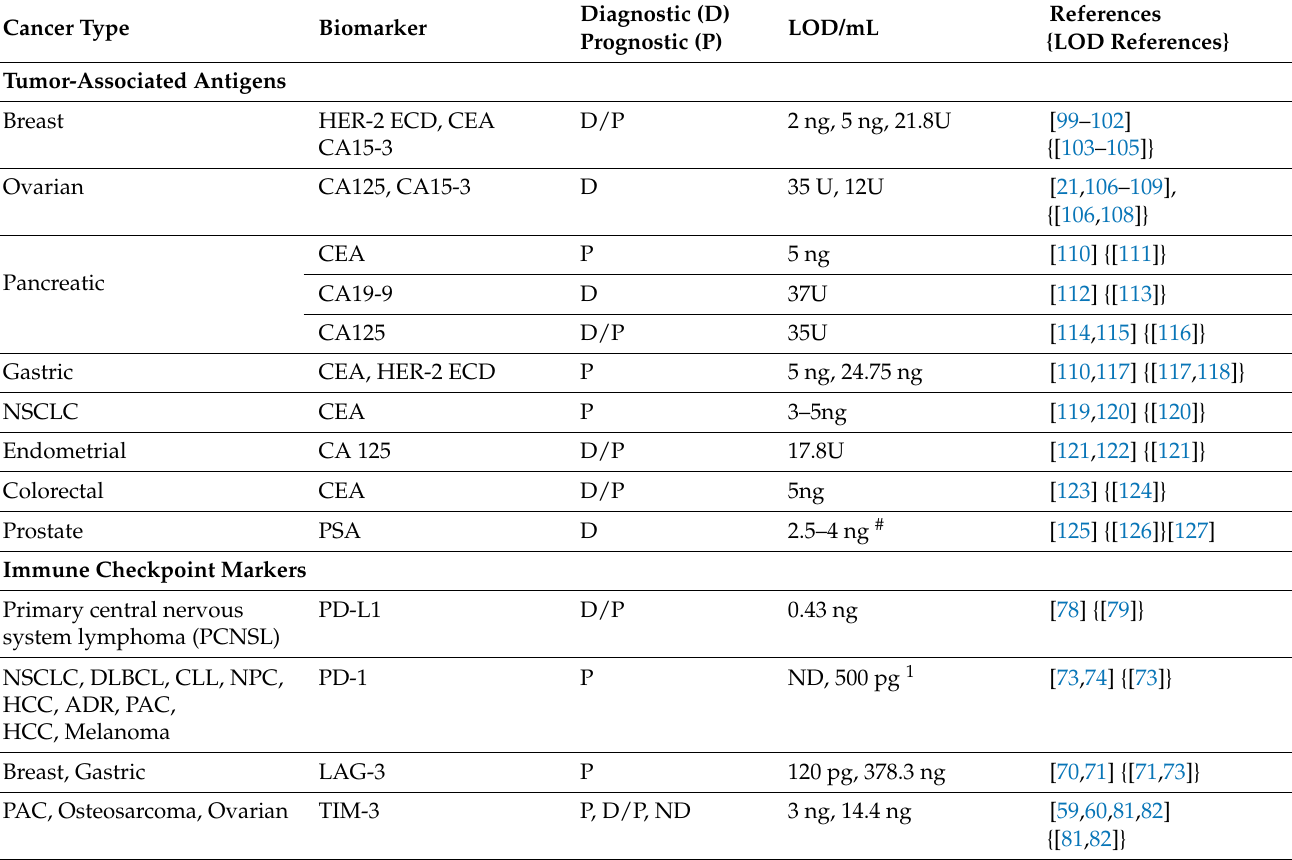
Table 3. Biomarkers and associated limits of detections (LOD) when using